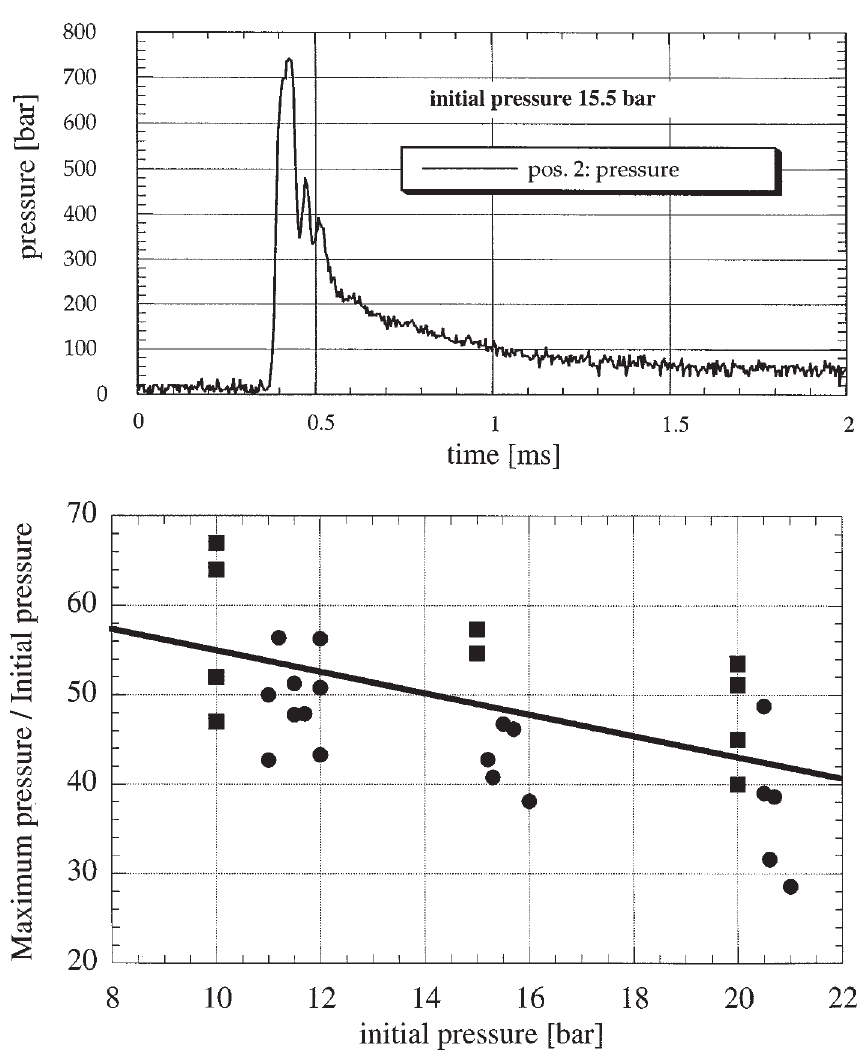
Fig. 6. Top diagram: Pressure–time history of a stable detonation propagating in a (cid:30) i = 30 mm pipe at 15.5 bar initial acetylene pressure. Bottom diagram: Detonation pressure ratios of acetylene as function of the initial acetylene pressure (squares and circles denote data from pipes with (cid:30) i = 10 mm and (cid:30) i = 30 mm,